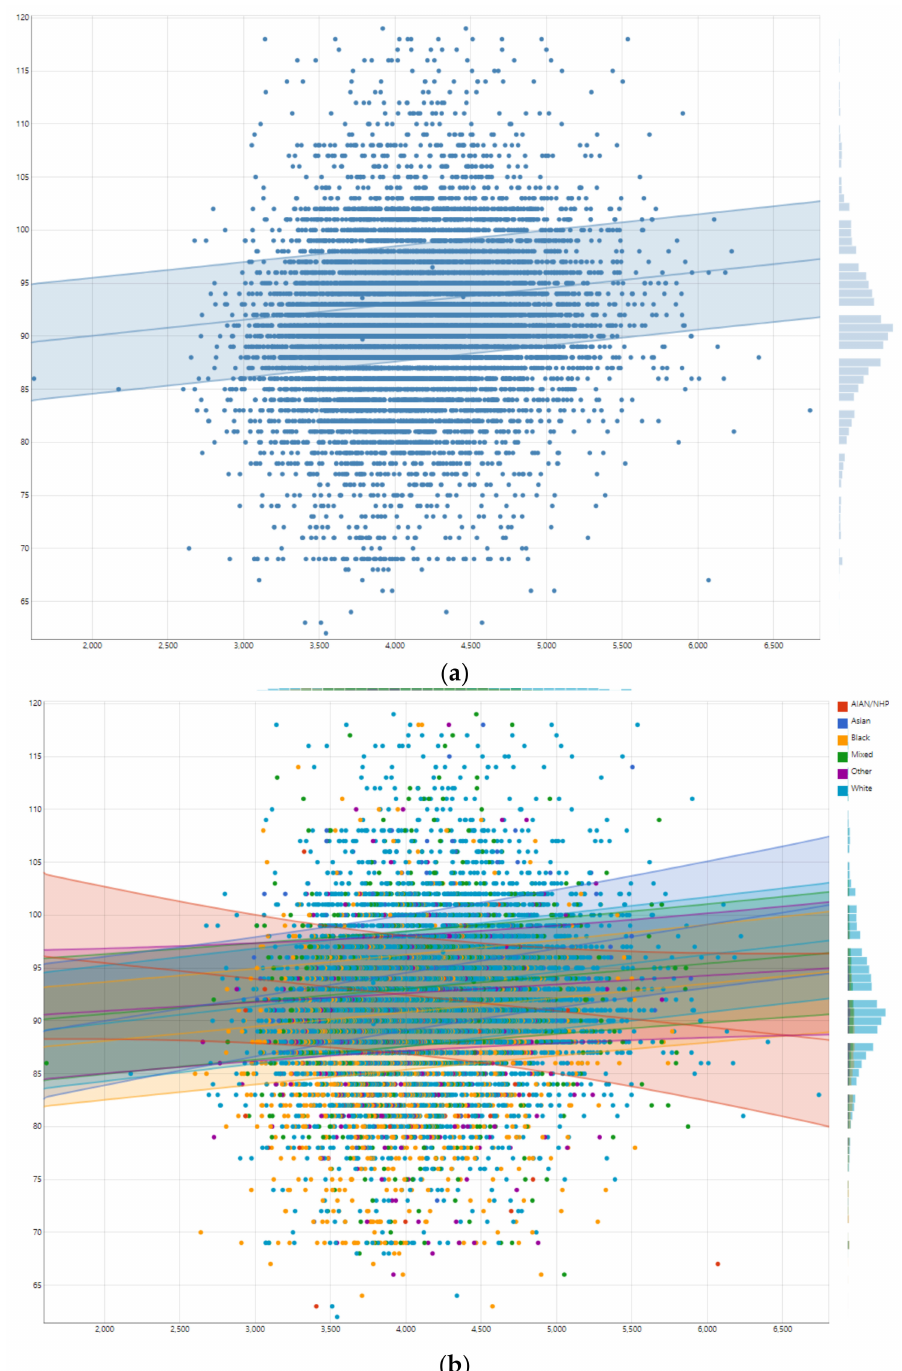
Figure A7. Association between the left superior temporal cortical surface area and parental educa- tion children’s reading ability. In these figures, X represents children’s left superior temporal cortical surface area and Y represents children reading scores. ( a ) Overall; ( b ) by